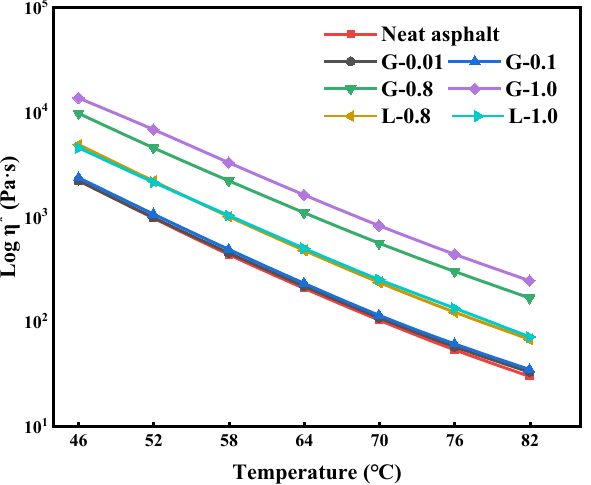
Figure 4. Complex viscosity of asphalts and mastics.